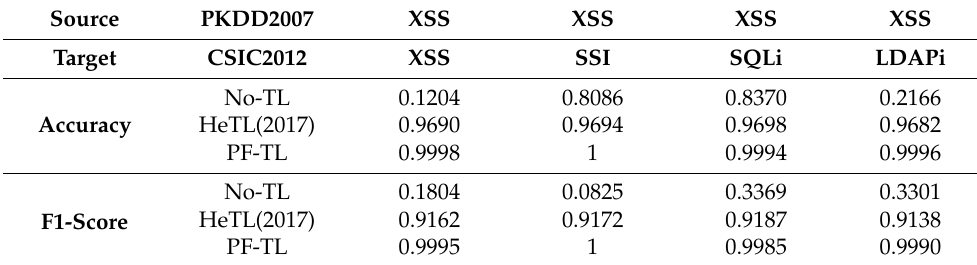
Table 9. Performance comparison of transfer learning on Scenario 2.